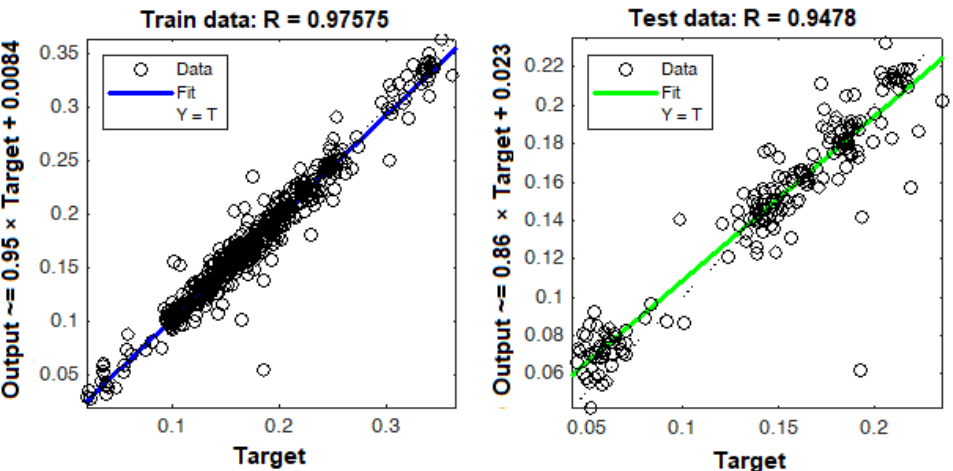
Figure 9. The variation of the measured and predicted reactive power, and also of the error for modelling with ANFIS grid partition method for testing stage.